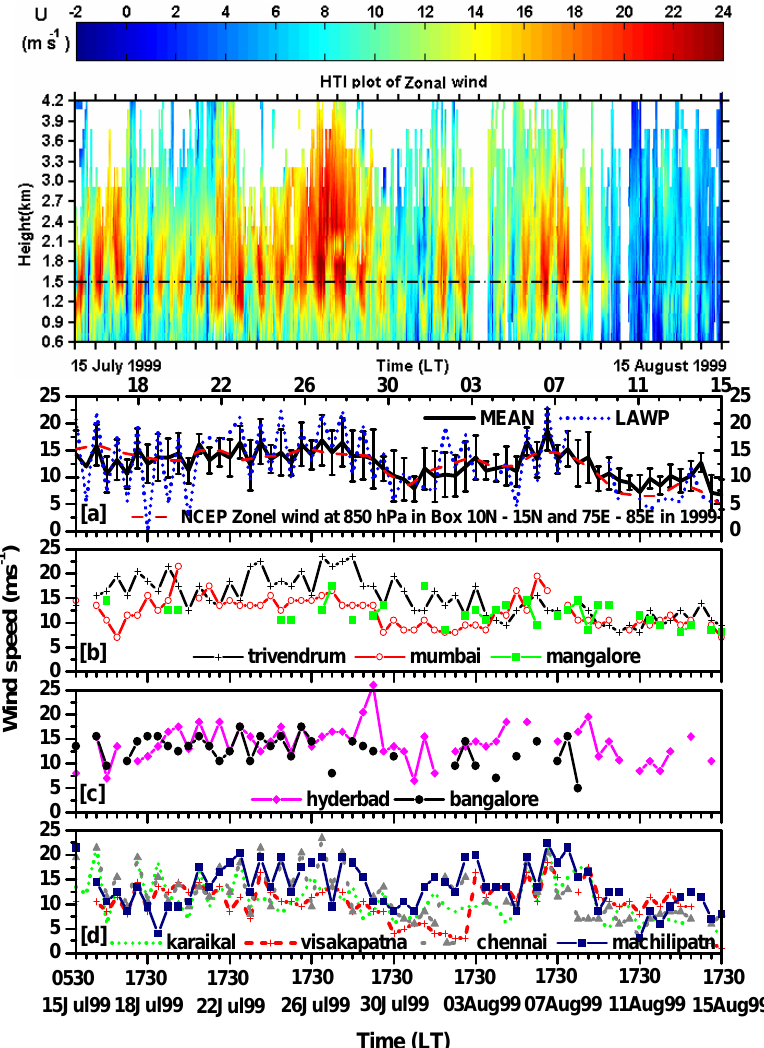
Fig. 3. (Top) Height-Time Intensity (HTI) map of zonal wind observed during 15 July–15 August 1999. (a) 850hPa level mean wind observed with the southern India IMD stations (solid line) the vertical bars are standard deviations, corresponding to the LAWP zonal wind at 1.5km (dotted line) and NCEP 850hPa mean zonal wind in grid 10 ◦ –15 ◦ N and 75 ◦ –80 ◦ E (dashed line). The wind speed observations of IMD stations over (b) west coast, (c) land stations in between the two coasts over India, and (d) east